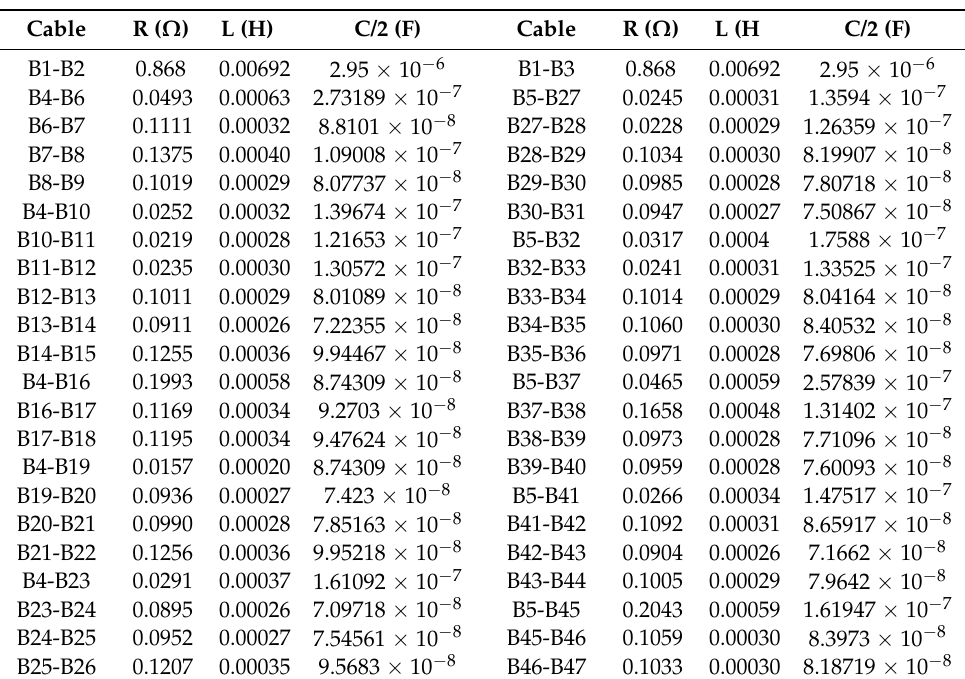
Table A5. Cable parameters: 42-turbine wind power plant.